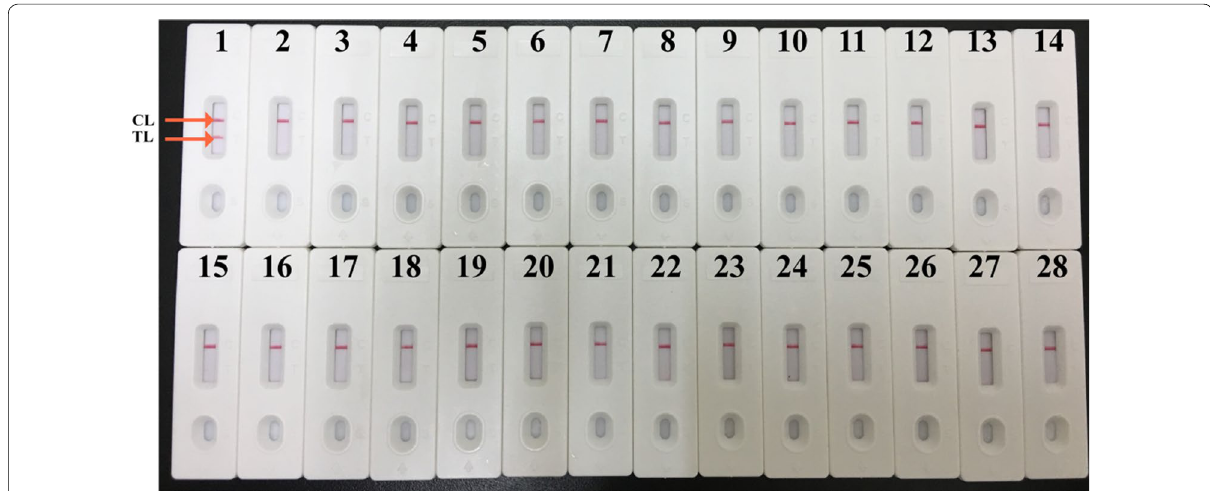
Fig. 5 Analytical specificity of MP-LAMP assay. The LAMP reactions were conducted using genomic DNA templates from different pathogens, and were monitored by LFB. Bisensor 1, MP standard strain (M129); biosensors 2-27, Mycoplasma genitalium , Mycoplasma hominis , Mycoplasma penetrans , Mycoplasma primatum , Ureaplasma urealytieum , Chlamydia trachomatis , Bacillus pertussis , Klebsiella pneumoniae , Mycobacterium tuberculosis , Mycobacterium avium , Streptococcus pneumoniae , Pseudomonas aeruginosa , Staphylococcus aureus , Haemophilus influenzae , Stenotrophomonas